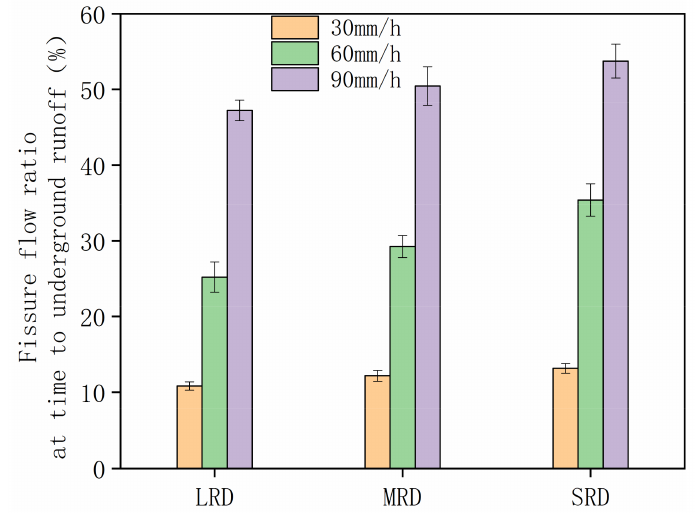
Figure 7. Fissure flow ratio under di ff erent rainfall